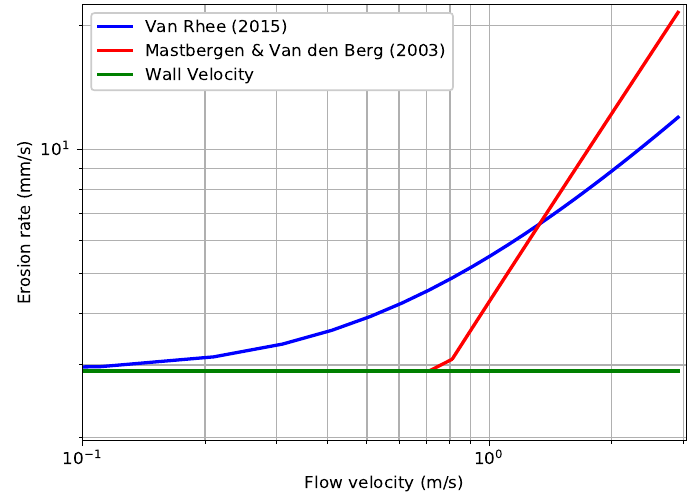
Figure 7. Comparison between breaching erosion formulations based on a uniform flow velocity; D 50 = 0.135 mm (see Table